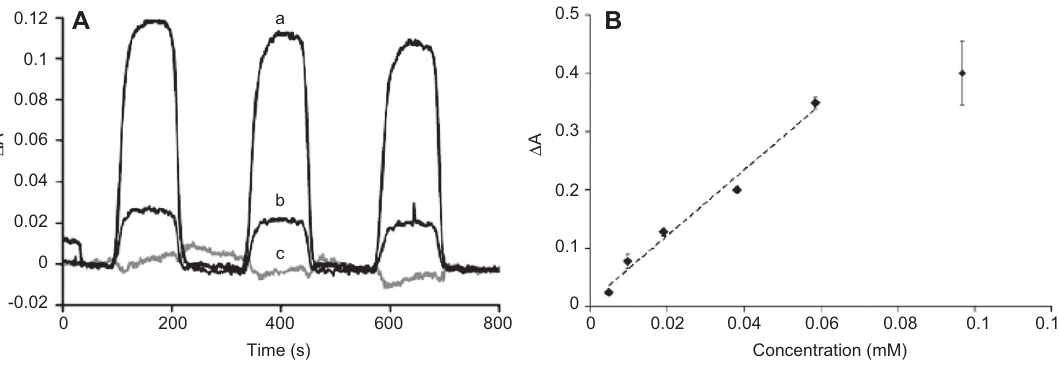
Figure 12 (A) Optical modulation of absorbance at 530 nm of 0.04 m [Re(dmpe)